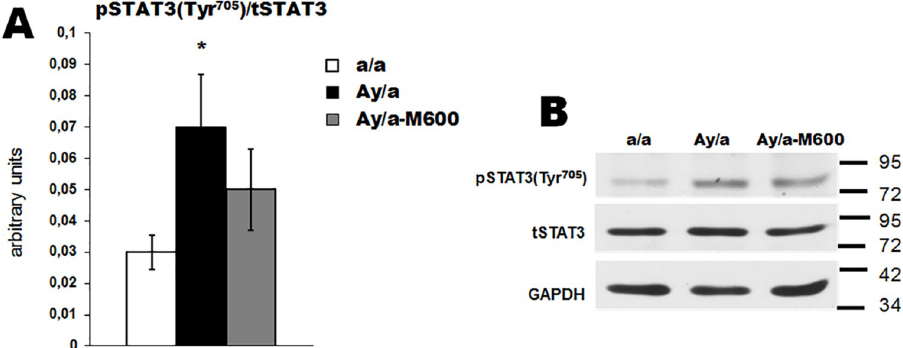
Fig 6. Phosphorylation of STAT3 in the hypothalamus of obese agouti-mice and the effect of metformin treatment. (A) The histograms for the ratio of the Tyr 705 -phosphorylated and non-phosphorylated STAT3. (B) The Western blotting for the Tyr 705 -phosphorylated STAT3. The data are presented as the M ± SEM . � —the difference between the Groups a/a and Ay/a is significant at the P < 0.05. In each group: n = 5.